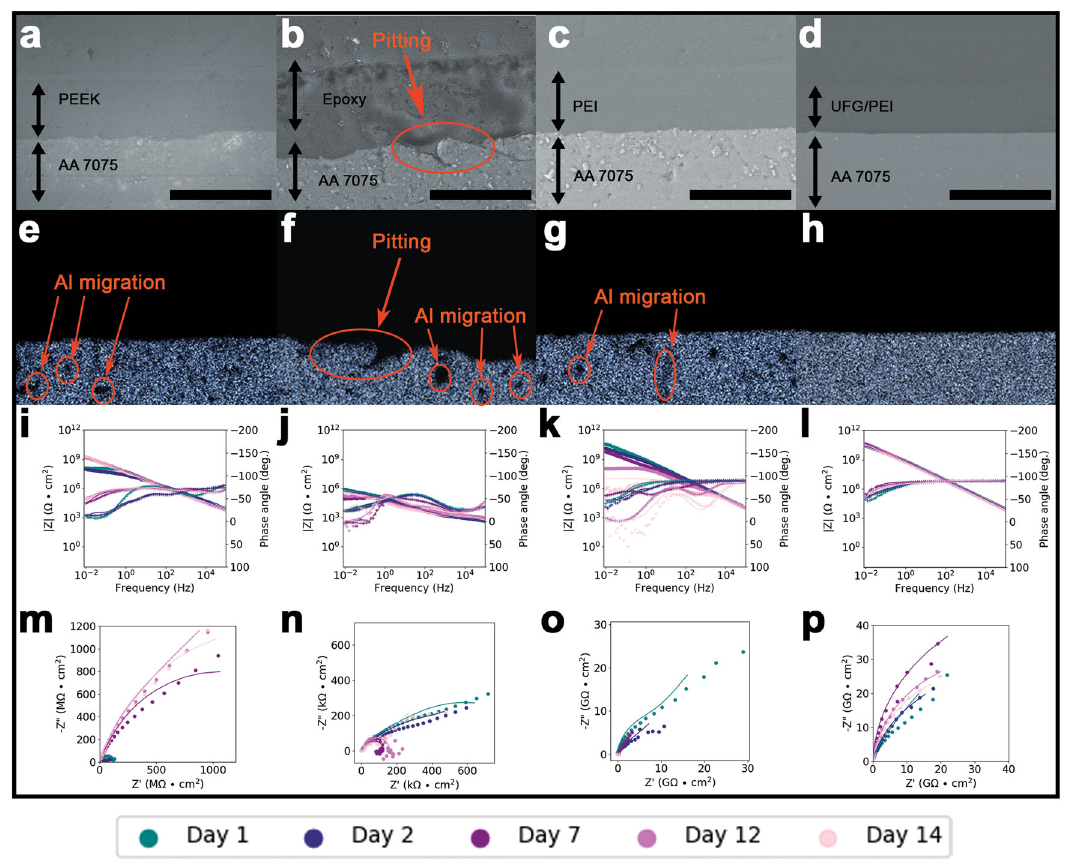
Fig. 6 Electrochemical processes, interface characterization, and corrosion mechanisms upon exposure to salt water at elevated temperature. Post-exposure SEM cross-sectional views of coatings, with scale bars equal to 50 µm, comprising ( a ) PEEK, ( b ) epoxy (2011) variation with no fi llers, ( c ) PEI, and ( d ) 3 wt.% UFG/PEI, respectively, coated onto AA 7075 substrates after exposure for 14 days to a 3.5 wt.% aqueous solution of NaCl at 70 °C. Aluminum EDX maps of substrates coated with ( e ) PEEK, ( f ) epoxy, ( g ) PEI, and ( h ) 3 wt.% UFG/PEI.